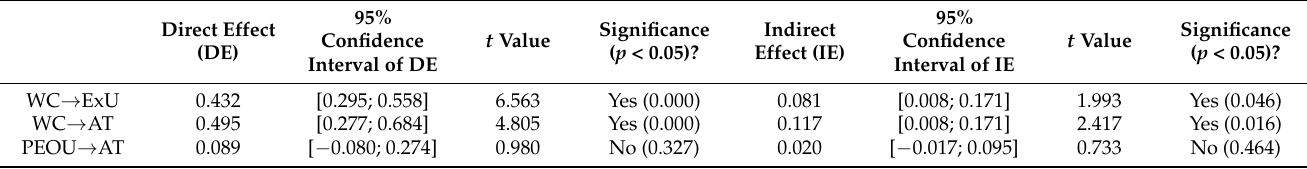
Table 7. Direct and indirect effect of extended TAM